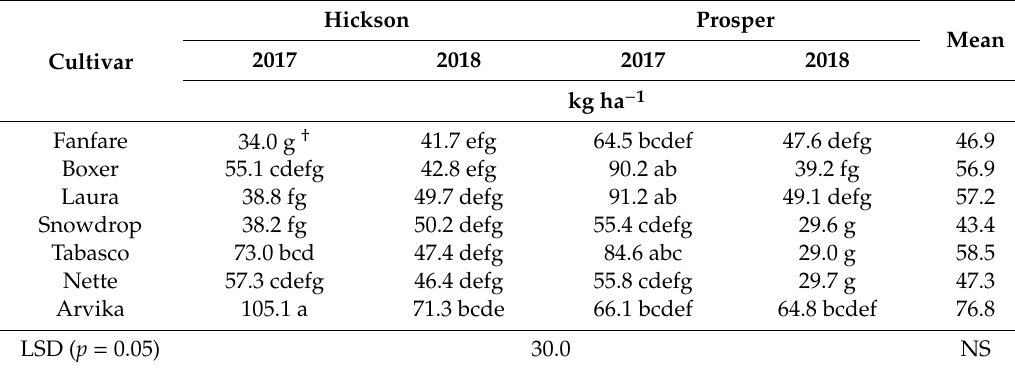
Table 8. Environment by cover crop interaction and mean across all environments of N accumulation in the shoot biomass of each cultivar in Hickson and Prosper, ND, USA, in 2017 and